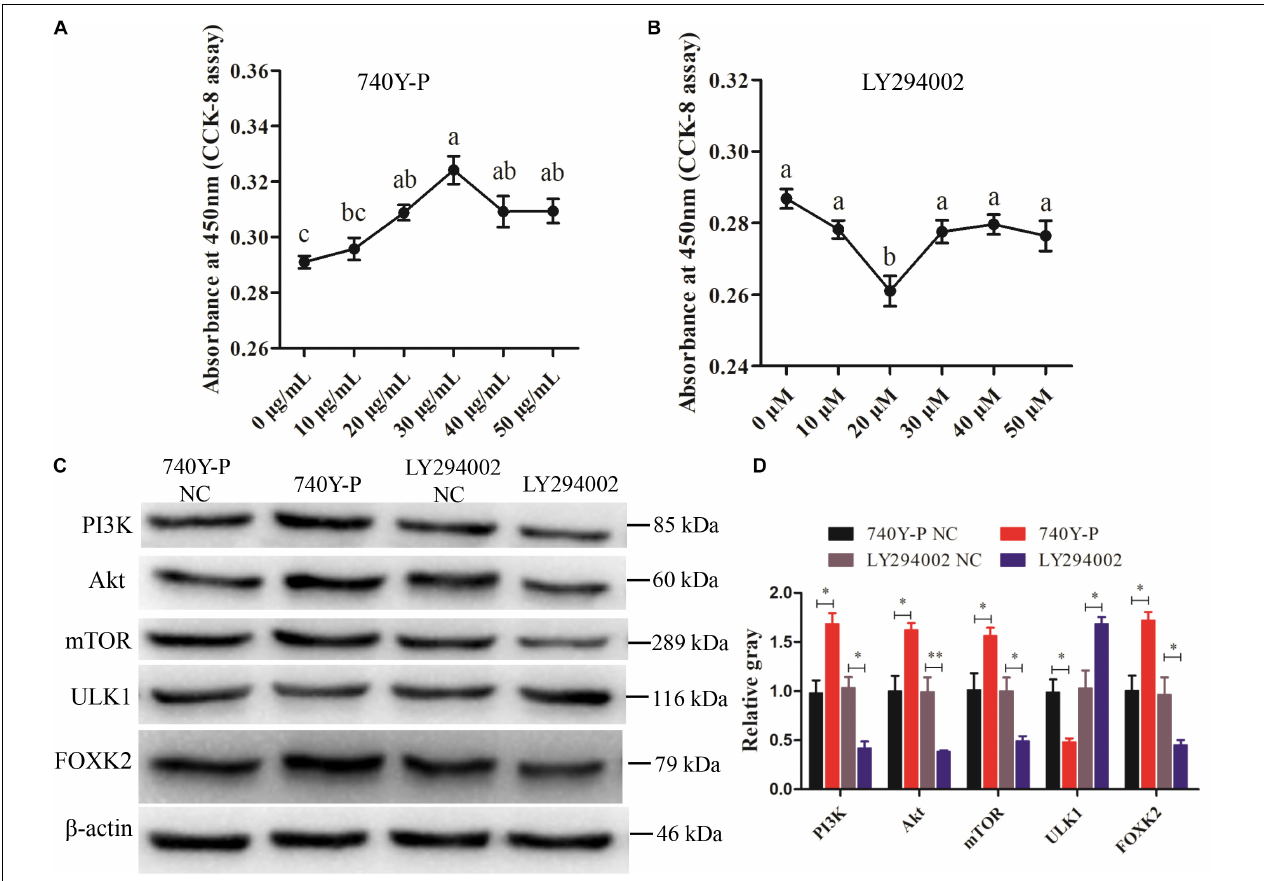
FIGURE 6 | Phosphoinositide 3-kinase (PI3K)/AKT/mammalian target of rapamycin (mTOR) pathway analysis. (A, B) Cell counting kit-8 (CCK-8) assay method was employed to determine the optimum concentration of PI3K activator (740Y-P) and PI3K inhibitor (LY294002) treatments. (C, D) The protein expressions of PI3K/AKT/mTOR pathway (PI3K, AKT, and mTOR) and downstream regulators [Forkhead box K2 (FOXK2) and ULK1] were detected by Western blot after the treatments of 740Y-P and LY294002. β -actin was used as a reference gene. Replications = 3. Data are presented as mean ± SE; * P < 0.05 and ** P <